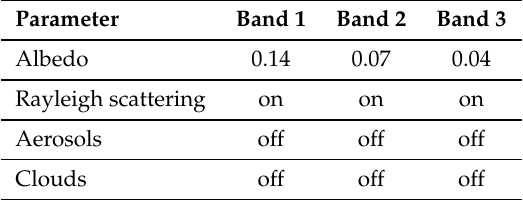
Table A5. Scattering parameters of scenario Rayleigh+Dark surface .